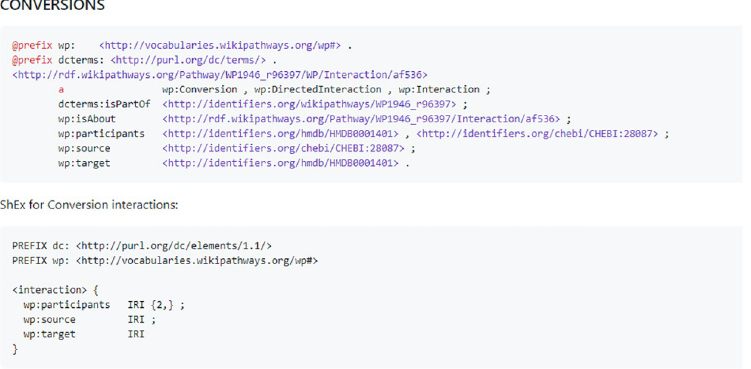
Fig 3. Example ShEx shape for the WikiPathways harmonized Conversion interaction element (RDF shown in the top half), that requires two or more participant IRIs and exactly one source IRI and one target IRI.